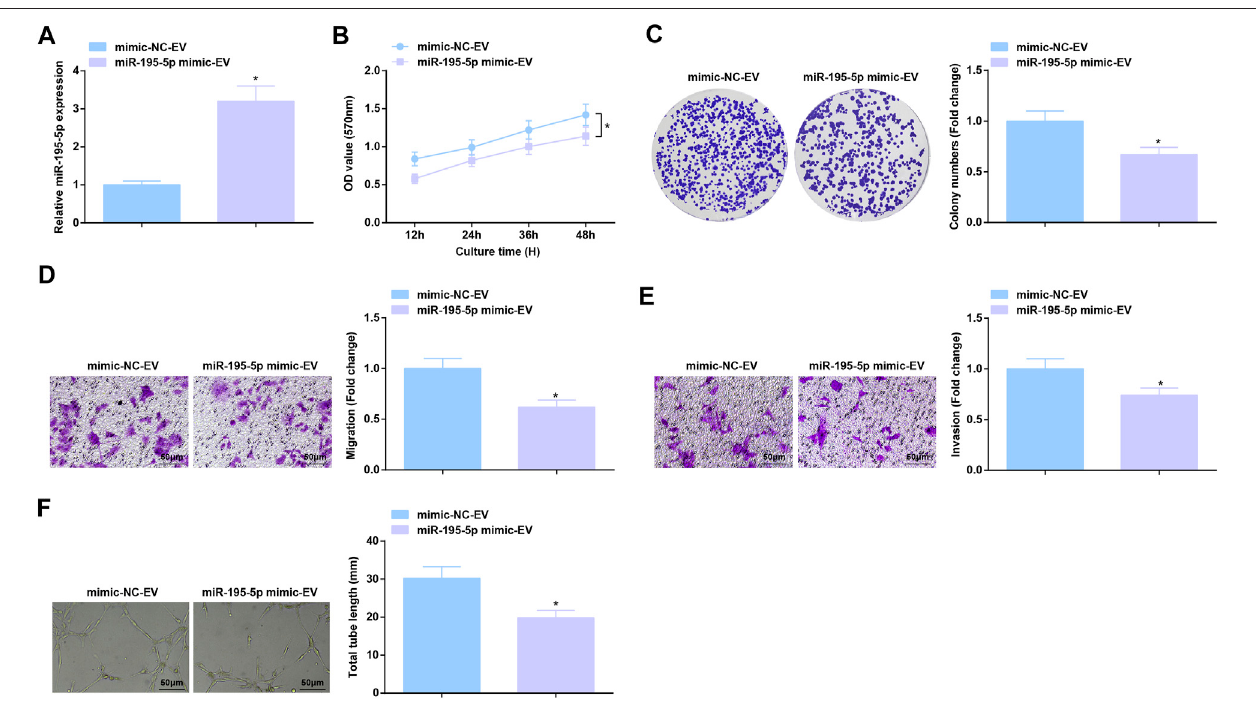
FIGURE 5 | Anti-angiogenic role of EVs expressing upregulated miR-195-5p. (A) RT-qPCR detection of miR-195-5p expression in HUVECs after co-culture with EVs; (B,C) ViabilityandcolonyformationabilityofHUVECsafterco-culturewithEVs; (D,E) MigrationandinvasionofHUVECsafterco-culturewithEVs; (F) Angiogenesis of HUVECs after co-culture with EVs. * p < 0.05 vs. the mimic-NC-EV group.